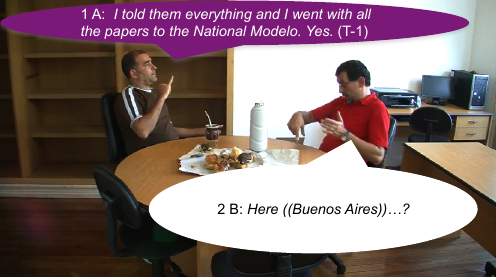
Figure 33. ‘…or there, Córdoba?’ , Signer B (right) initiates repair with two pointing signs (see previous frame for the first pointing sign). In this second pointing sign, he changes the position of his head upwards and produces a place refe- rence sign with the other hand ( ‘Córdoba’ ), maintaining both signs held until Signer B (left) confirms one of the options ( ‘Here, here’